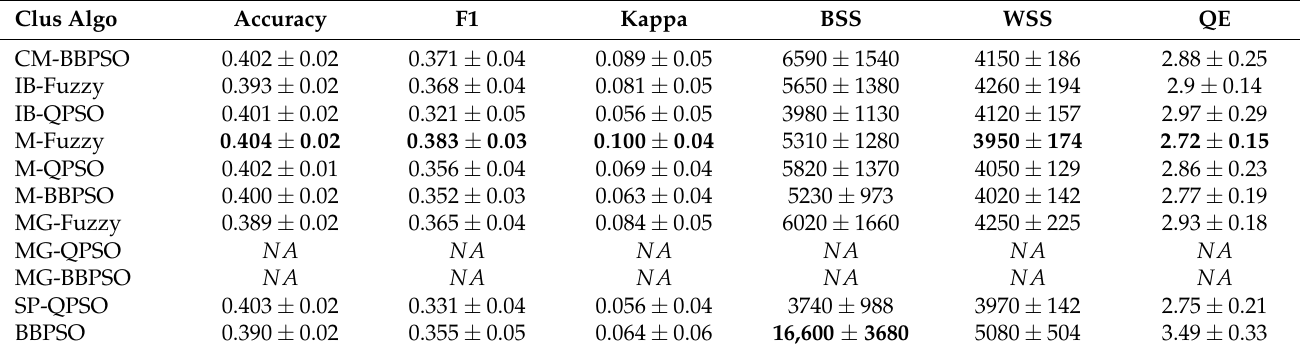
Table 2. Performance of CM-BBPSO and other clustering algorithms on CMC dataset with the best result produced by the algorithm presented in bold.